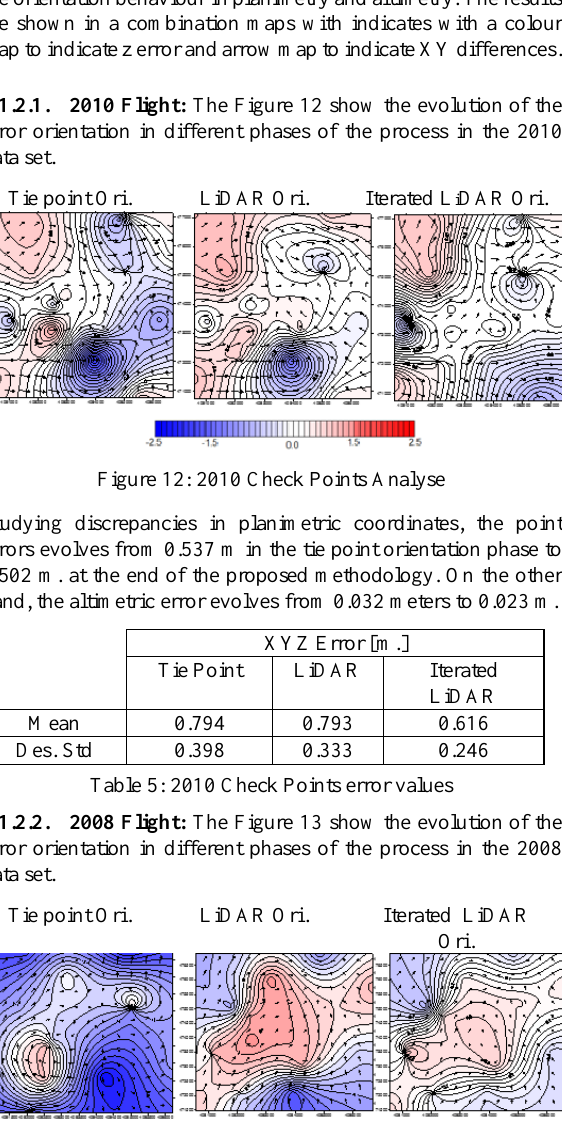
Figure 11: 2001 error histogram 4.1.2. Check Points Analyse: GPS Check points study are measured in stereo after each orientation step in order to analyse the orientation behaviour in planimetry and altimetry. The results